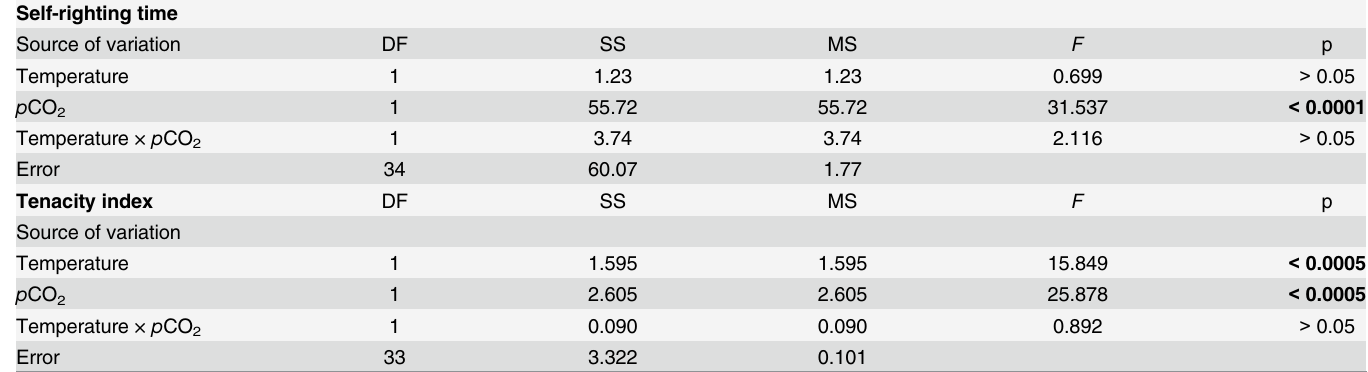
Table 5. Concholepas concholepas. Two-way ANOVAs investigating the effect of different combinations of temperature (15 and 19°C) and p CO 2 (500 and 1400 μ atm) levels on two behavioural responses measured in small juveniles after 5.8 months of rearing in the experimental conditions (Fig 3a and 3b). Values in bold are significant at p < 0.05. Tenacity index data set was log transformed to meet assumptions of normality.